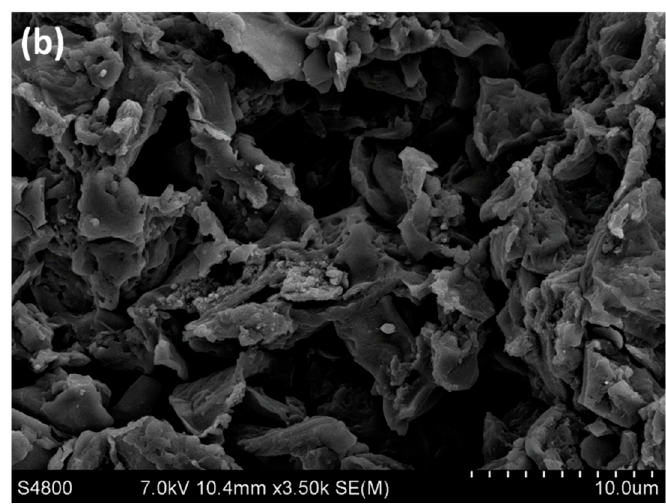
Figure 2. SEM micrographs of ( a ) AC-CA and ( b ) AC-PA samples.